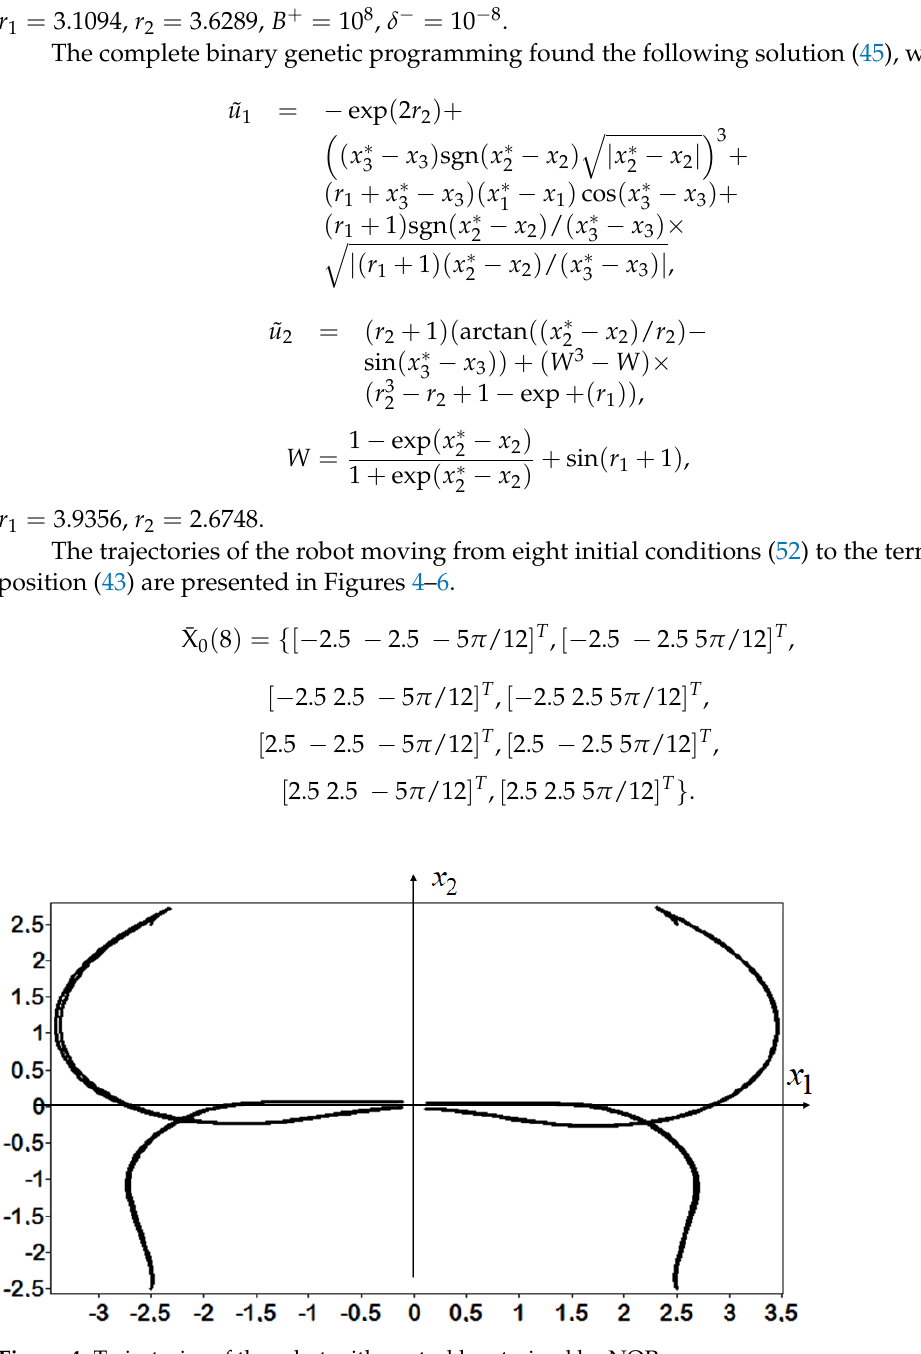
Figure 4. Trajectories of the robot with control law trained by